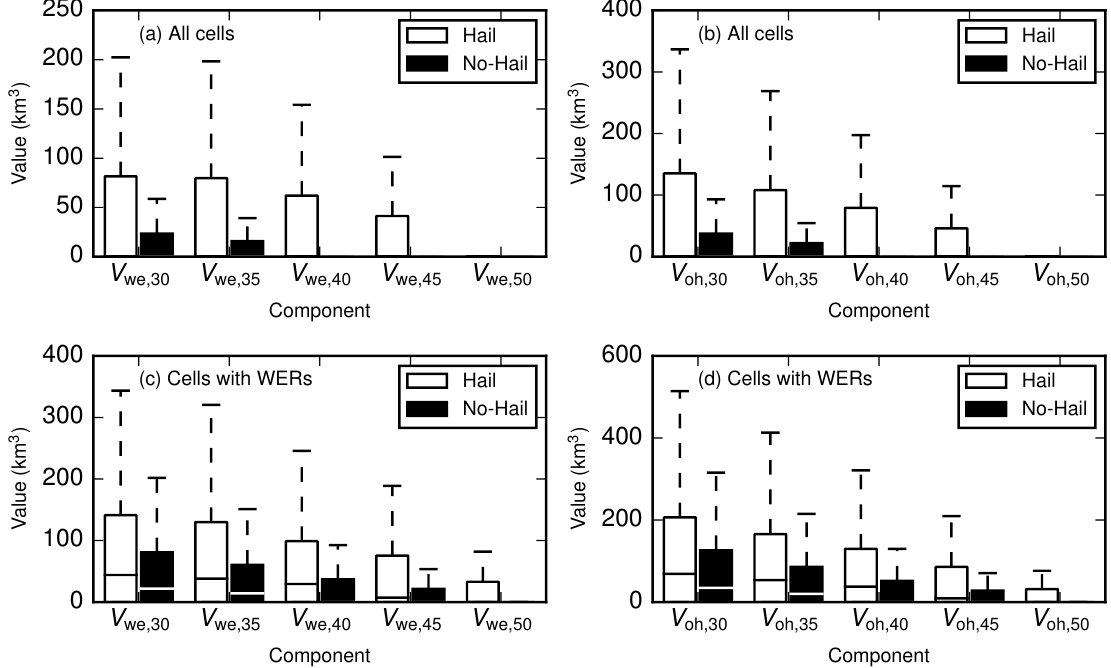
Figure 10. Box plot of ( a , c ) V we, R Result comparison of ( a , b ) all cells in the sample set and ( c , d ) cells with